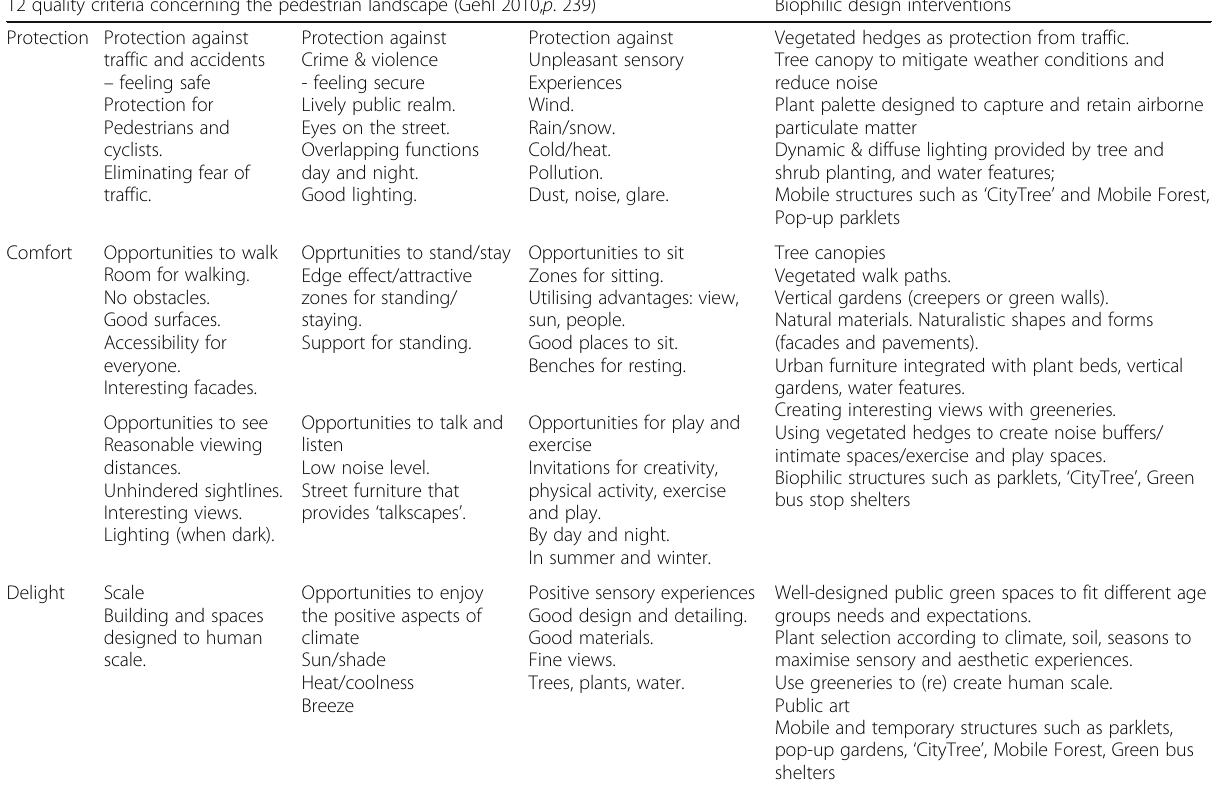
Table 3 Gehl ’ s 12 quality criteria concerning the pedestrian landscape along with added biophilic design interventions 12 quality criteria concerning the pedestrian landscape (Gehl 2010, p .